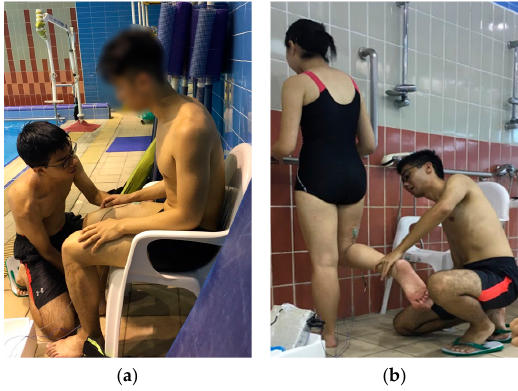
Figure 3. (a) RF MVC testing. (b) BF MVC testing. Figure 3. ( a ) RF MVC testing. ( b ) BF MVC